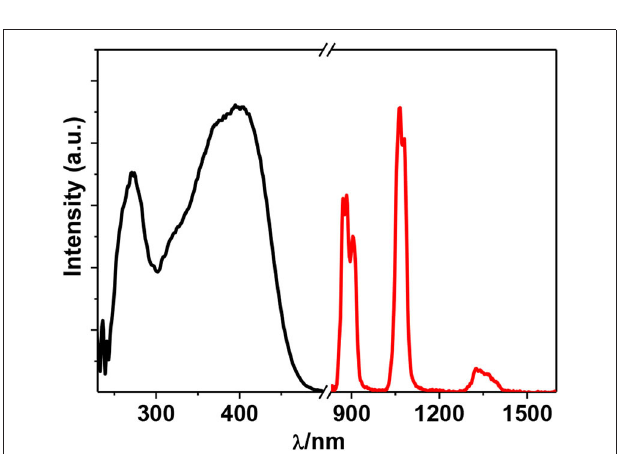
FIGURE 4 | Lanthanide luminescent response of 1 (5 µ M) to H 2 PO 2 − anion in CH 3 CN ( λ ex = 395nm).